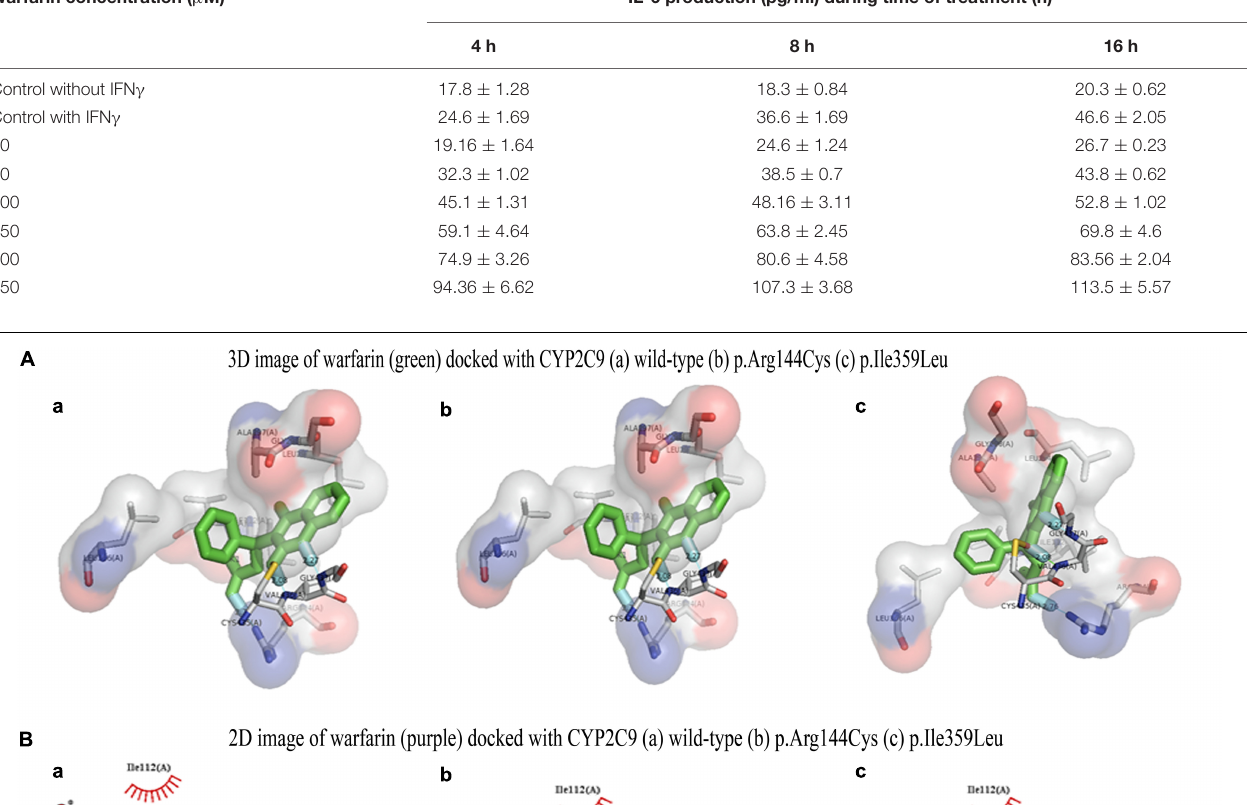
TABLE 4 | The increased levels of IL-6 observed in HeLa cells on varying warfarin concentration. Warfarin concentration ( µ M)